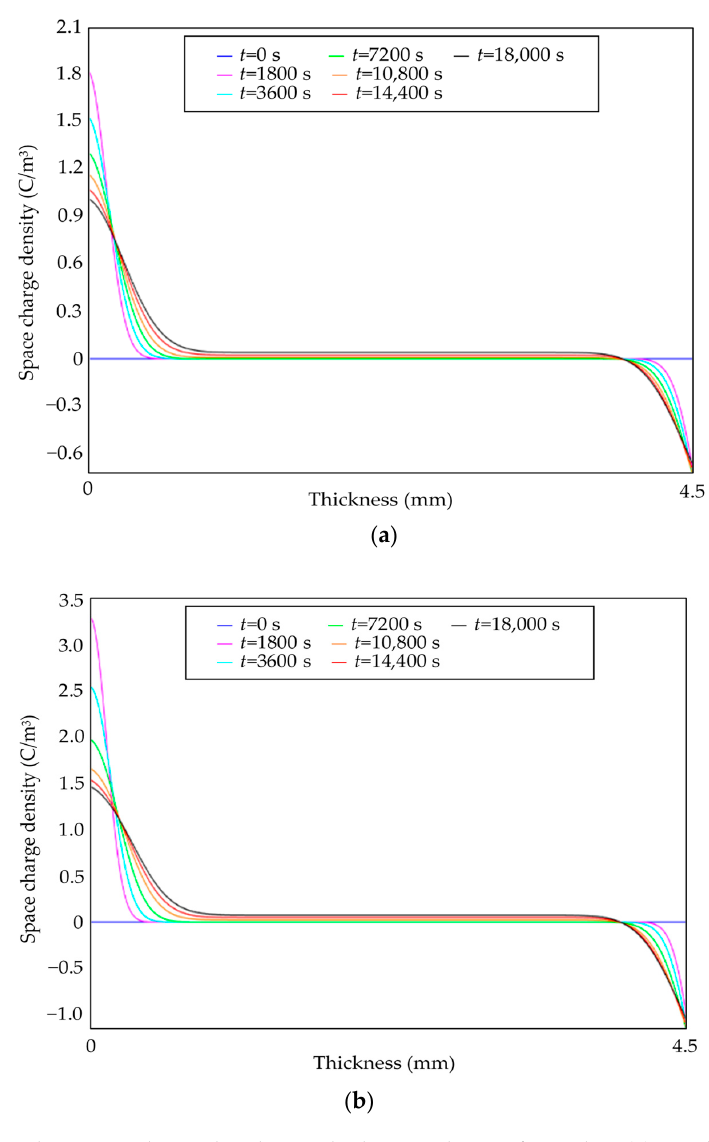
Figure 11. Simulation results under the applied DC voltage of 67.5 kV: ( a ) insulation with the temperature difference of 15 °C; ( b ) insulation with the temperature difference of 30 °C.